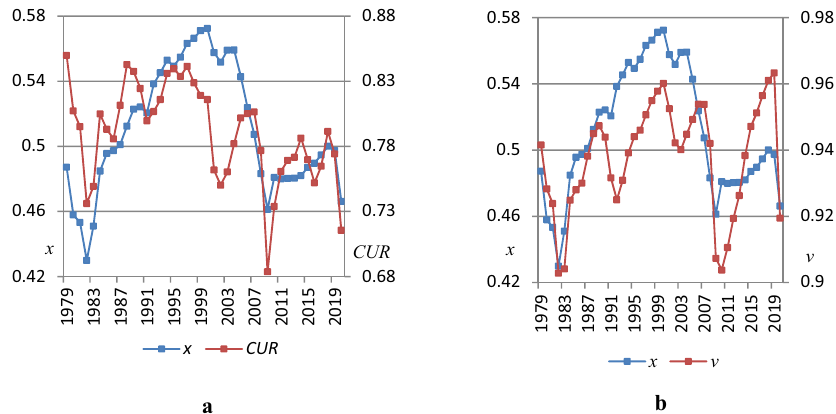
Fig. 16 The indicators of capital accumulation in the USA, years 1979–2020; a output-capital ratio x and industrial capacity utilization rate CUR ; b output-capital ratio x and employment ratio v